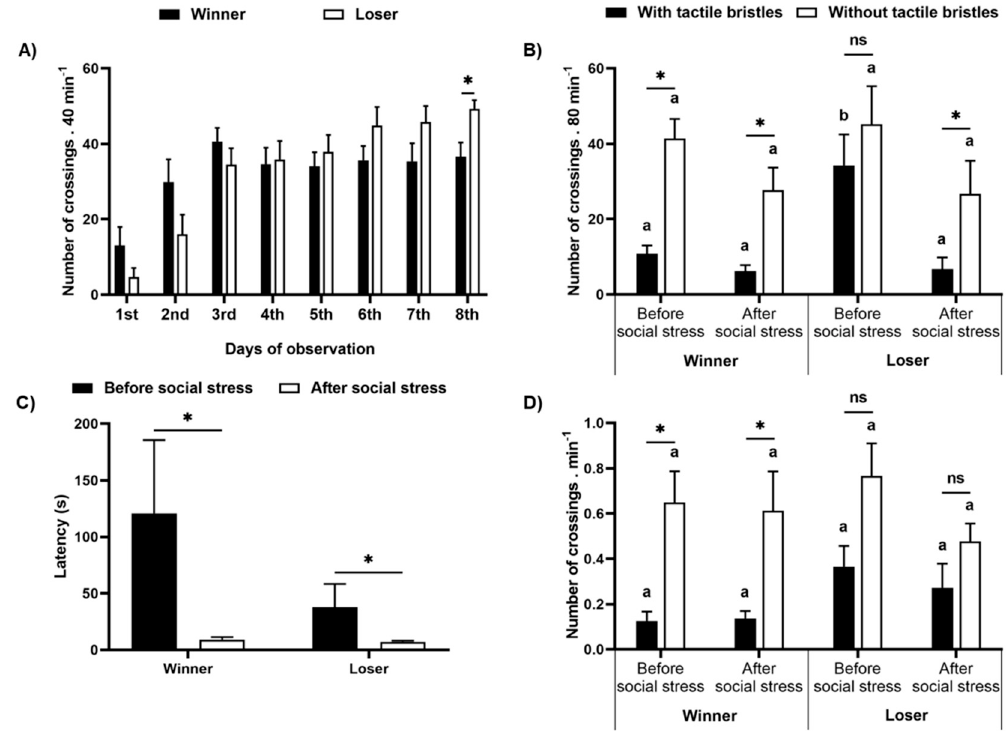
Figure 7. Winner and loser fish responses to preference and motivation tests. The number of crossings through the tactile bristles during the eight days fish were exposed to the tactile device ( A ); and the areas with and without bristles in the preference test, both before and after aggressive interaction ( B ). The latency to access the tactile device ( C ) and the number of crossing through the areas with or without tactile bristles ( D ) during the motivation test, both before and after the social stress, for winner and loser fish. Data are mean ± SE. Mixed model ANOVA followed by ( A ) Planned comparisons or ( B – D ) SNK post hoc test. The asterisk indicates significant differences between ( A ) ranks within days; ( B , D ) the areas with and without tactile bristles within ranks in the periods; ( C ) periods before and after stress within ranks. ( B , D ) letters compare periods before and after aggressive interaction for winner and loser fish. Similar letters indicate no significant